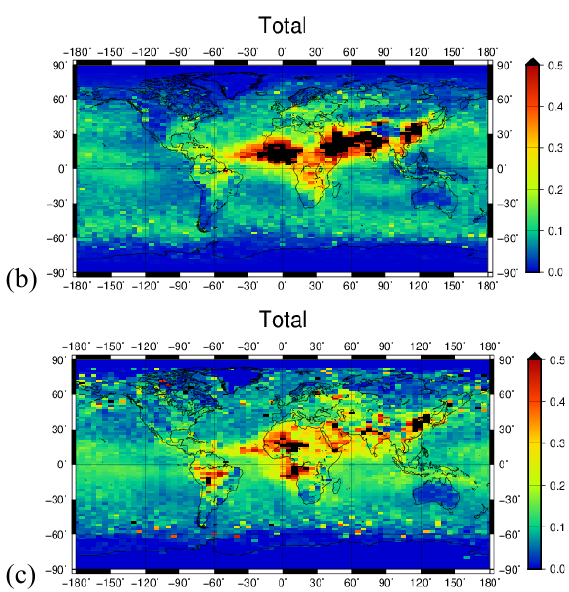
Figure 2. Same as Fig.1e but (a) CALIOP NASA standard product Version 3 (CALIOP-ST Ver.3), (b) CALIOP NASA standard product Version 4 (CALIOP-ST Ver.4), and (c)MODIS standard (MODIS-ST) product (Level2, MAC04S0.002, "AOD_550_Dark_Target_Deep_Blue_Combined" ).